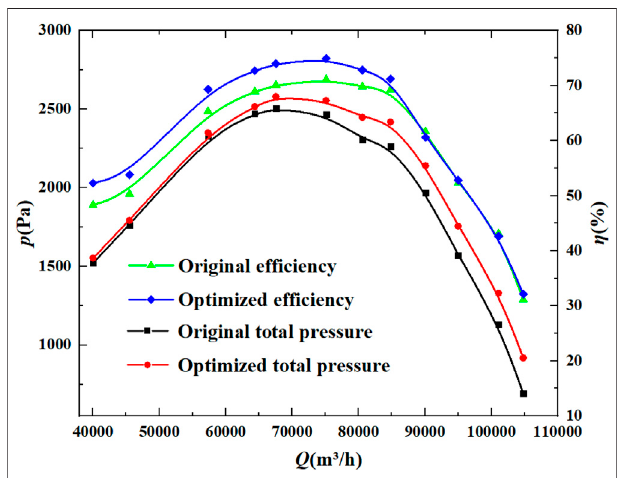
FIGURE 13 | Fan performance curves original and optimized obtained by numerical